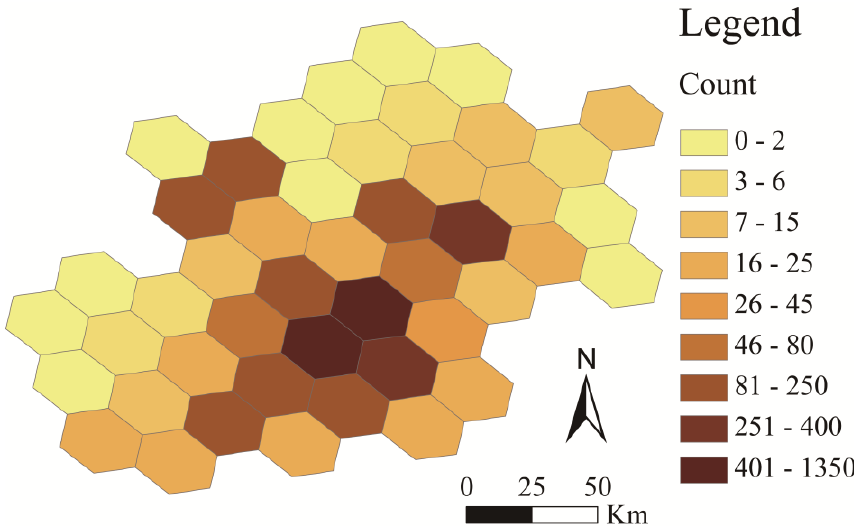
Figure 11. The heat map of POI distribution expressed in hexagonal grid using GeoSOT 14th level grid information transformation.